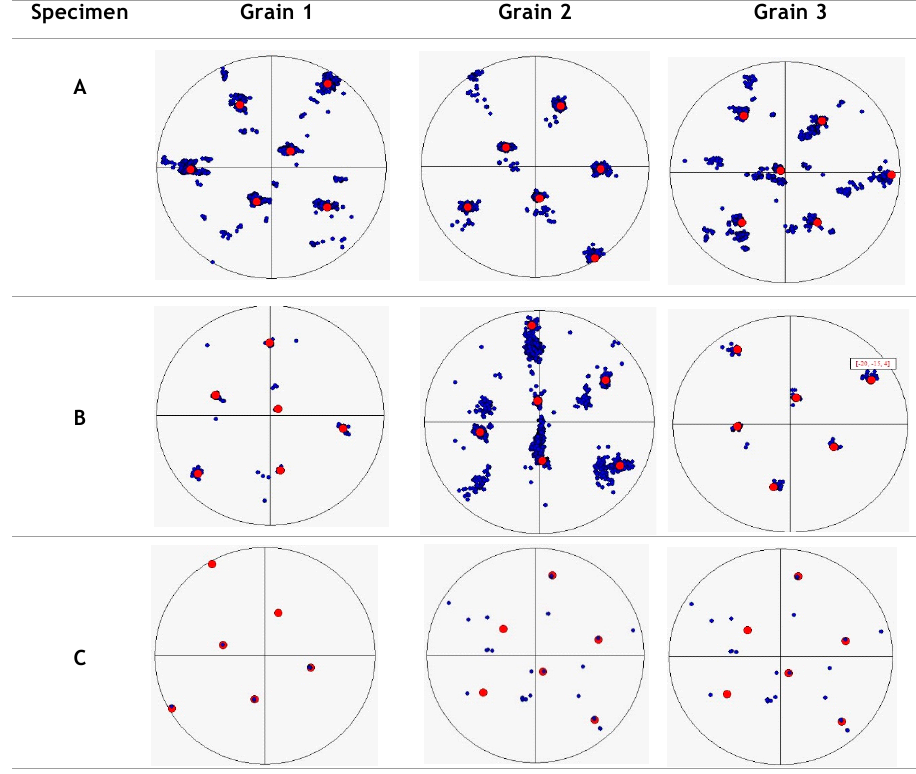
Figure 12. Superimposed discrete pole figures of (110) poles of reconstructed β -grains (the red dots) and the (0001) poles of clustering α / α′ lathes (the blue dots) for samples A, B and C.